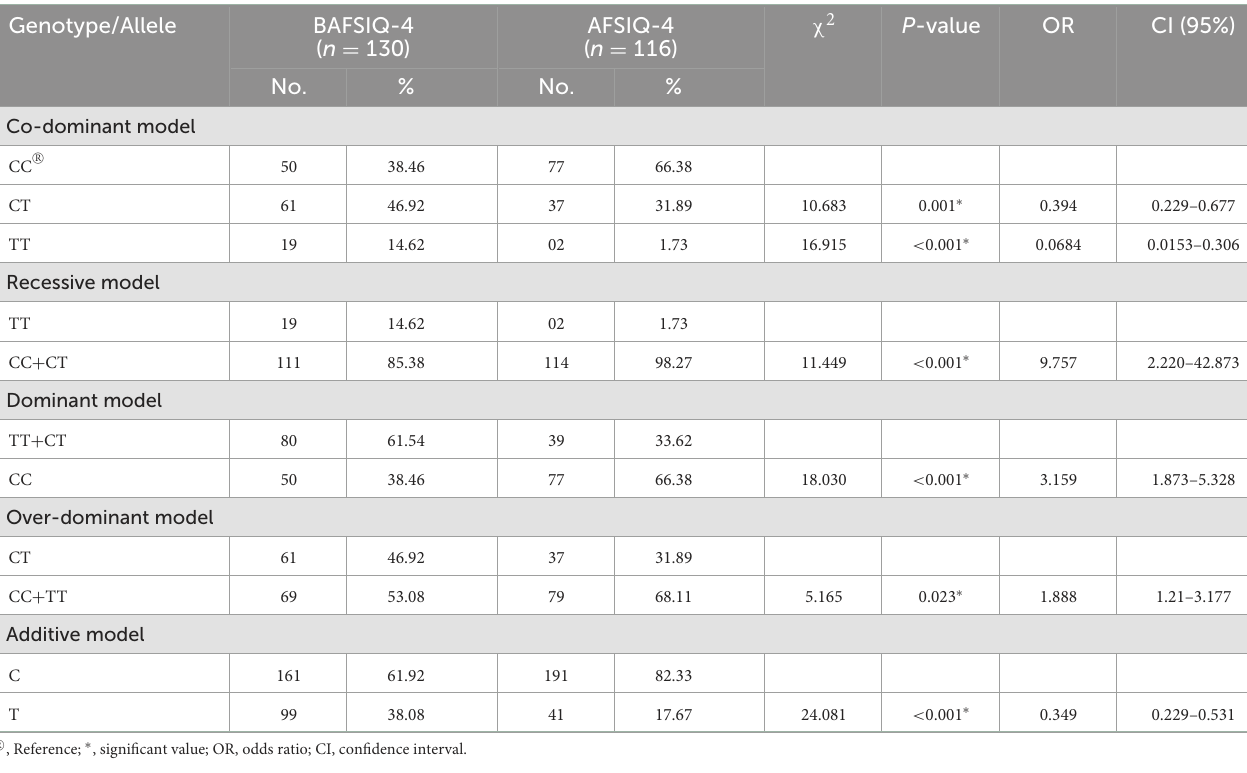
TABLE 4 BDNF gene polymorphism under co-dominant, recessive, dominant, over-dominant, and additive models in individuals with below average FSIQ-4 (BAFSIQ-4) and average FSIQ-4 (AFSIQ-4). Genotype/Allele